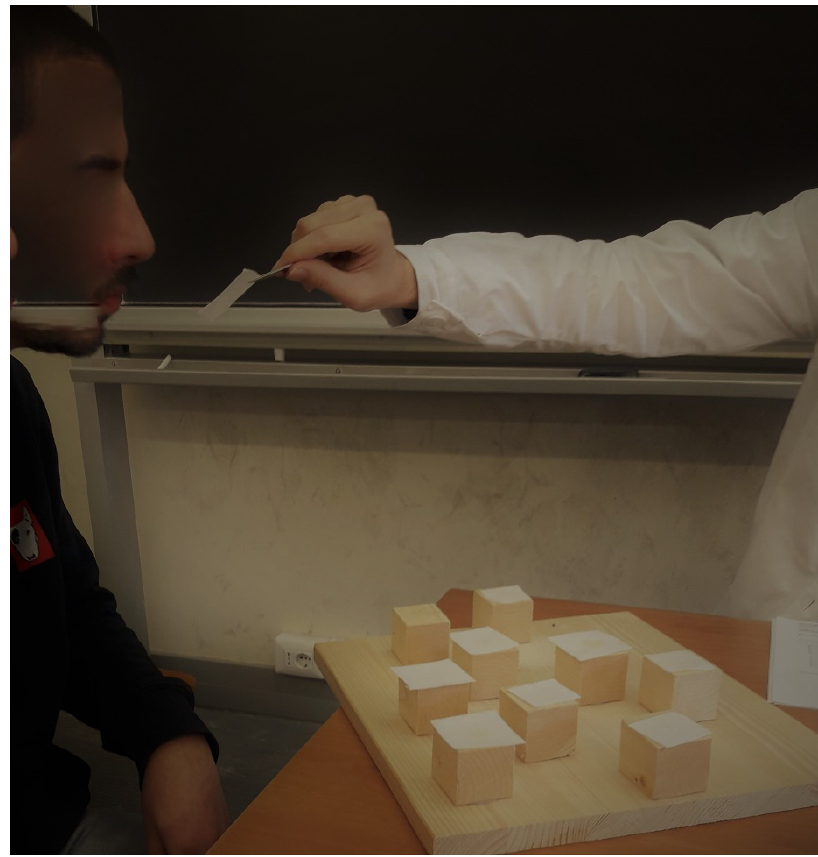
Figure 1. Example of the Olfactory Corsi Block Tapping Test (OCBTT).